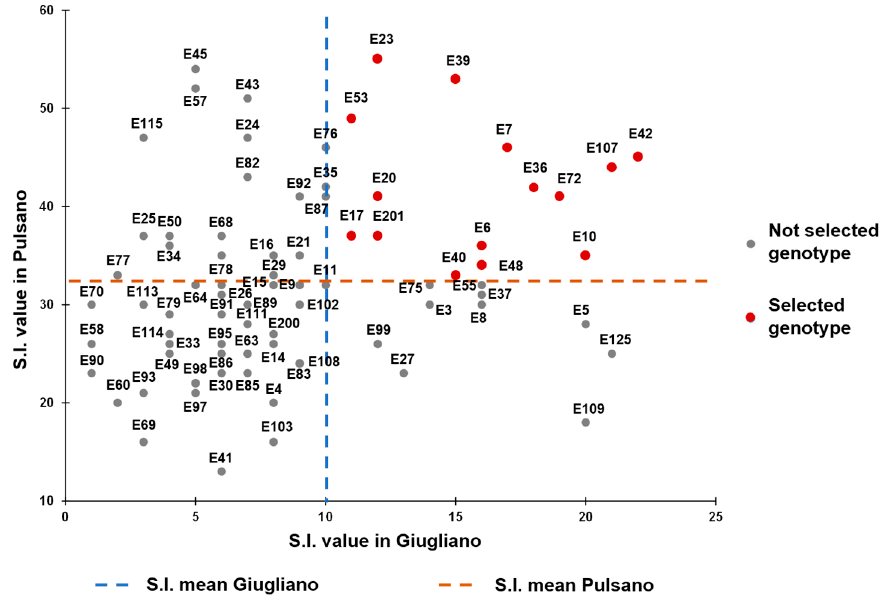
Figure 4. Selection Index (SI) estimated in the fields of Giugliano and Pulsano on 81 tomato landraces. The SI was calculated on FS, TNF and YP data collected in the two fields.